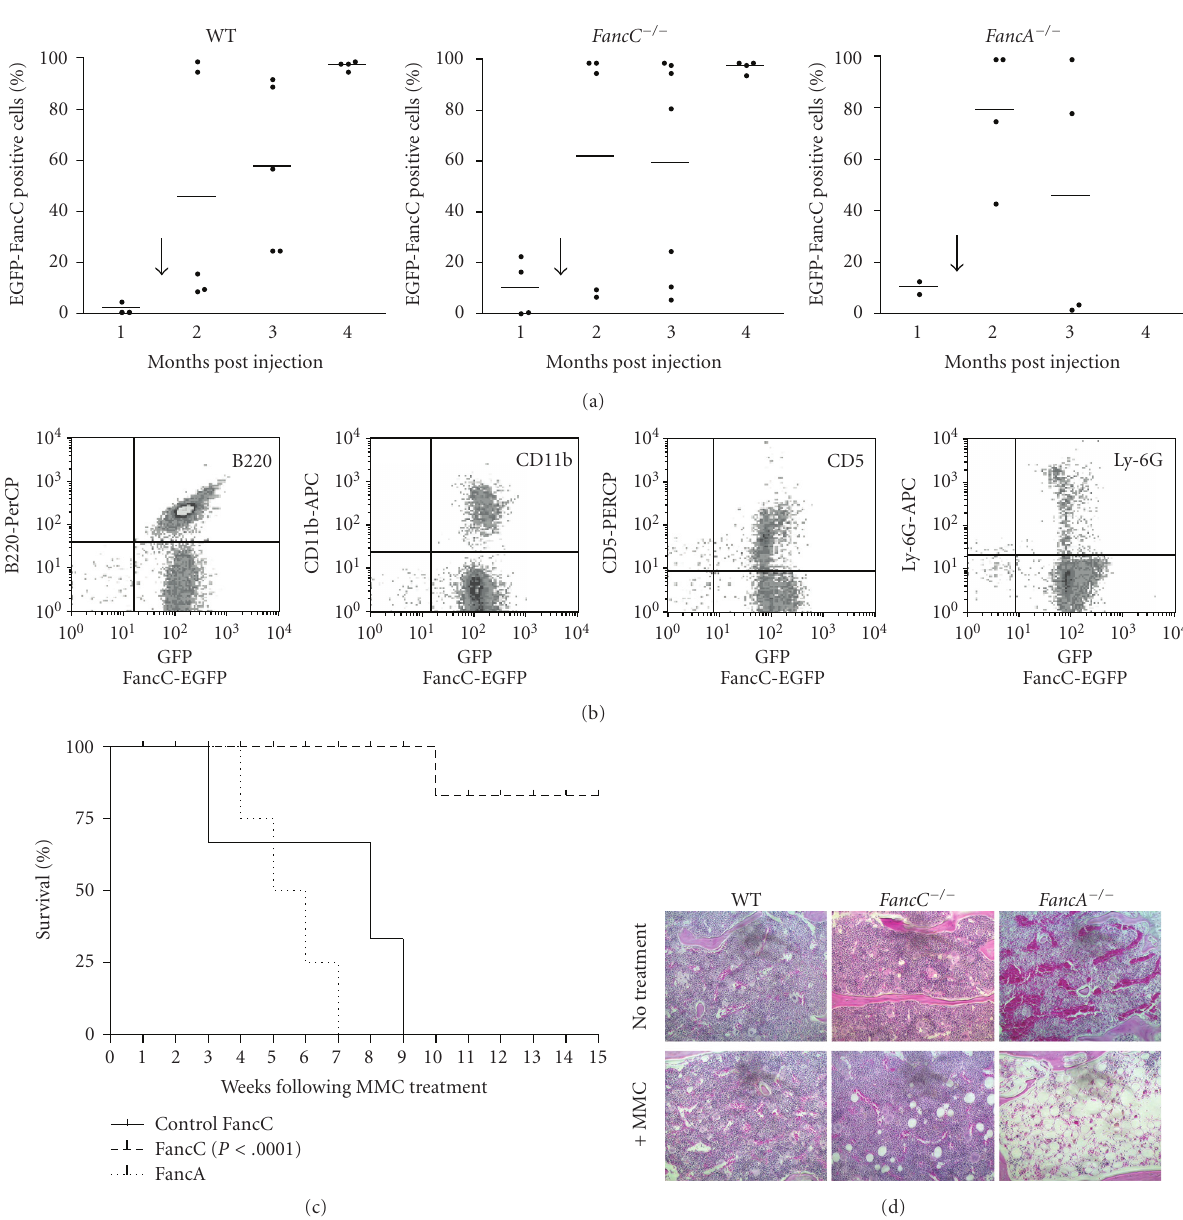
Figure 7: Prevention of BM failure following IF gene transfer into mice with BM aplasia. (a) FancC-EGFP transgene expression in peripheral blood cells of preconditioned IF-injected wild type (WT), FancC − / − , and FancA − / − mice that received chronic MMC treatments at 7 weeks following IF-injection as a function of time. The arrow represents the start of weekly MMC injections (0.3 mg/kg). Each dot represents the FancC-EGFP expression of an individual IF-injected mouse. Horizontal line: mean value. (b) Representative cytometric profiles of FancC- EGFP expression in peripheral blood cell lineages from FancC − / − preconditioned IF-injected mice at 15 weeks following weekly MMC treatment. (c) Survival of preconditioned IF-injected FancC − / − ( n = 6) and FancA − / − ( n = 4) mice following MMC treatments. Control FancC − / − mice represent uninjected mice treated weakly with MMC ( n = 22). (d) Representative histological appearances of the sternum from preconditioned and IF-injected mice at four months following IF injections (no treatment) and at 15 weeks following weekly MMC treatment (+ MMC). Hematoxylin-eosin staining: original magnification 200 ×